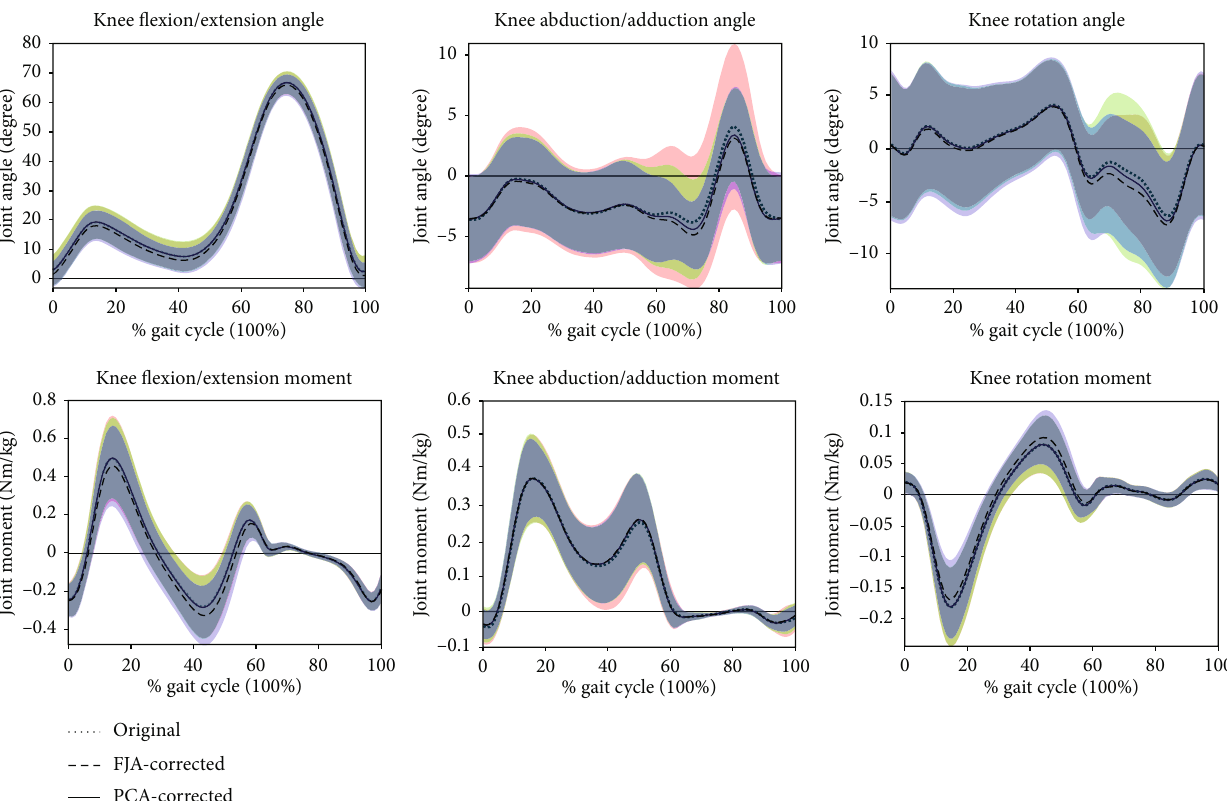
Figure 2: The knee angles and moments of healthy participants during a gait cycle. The shaded areas represent the standard deviation for the original